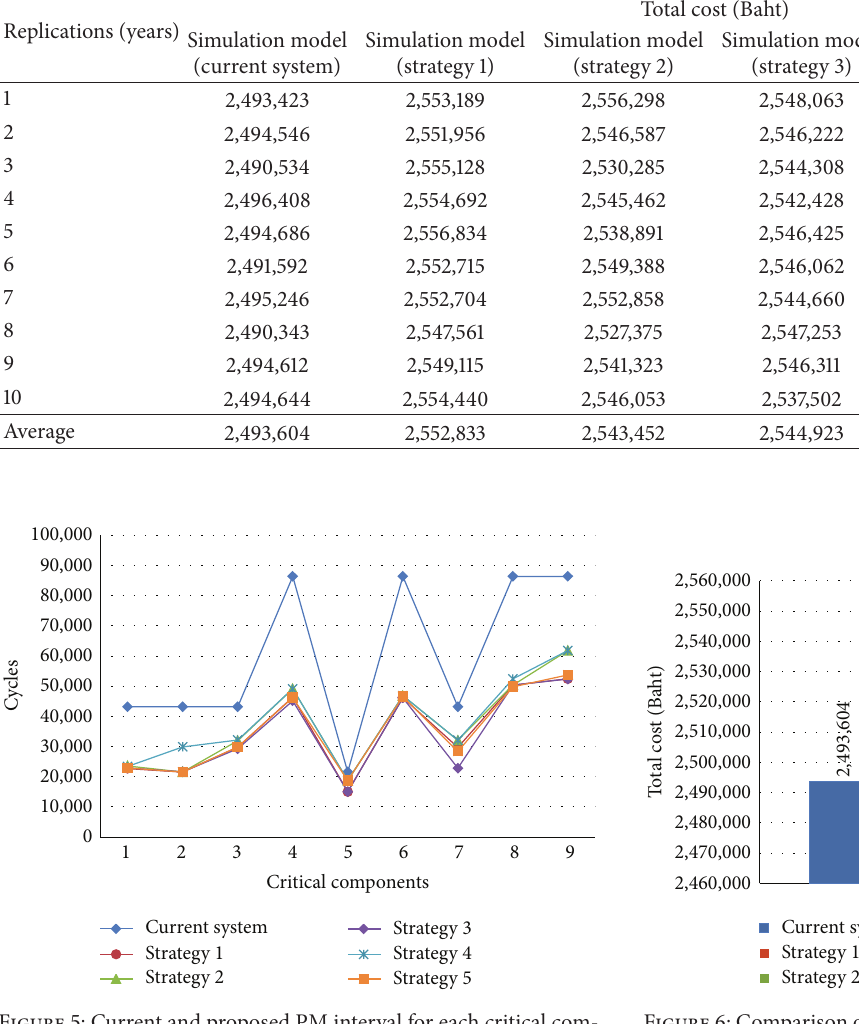
Figure 5: Current and proposed PM interval for each critical com- ponent.